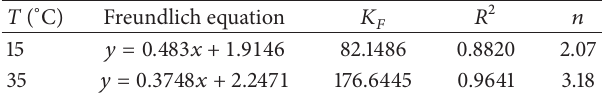
Table 5: Freundlich isotherm parameters at different